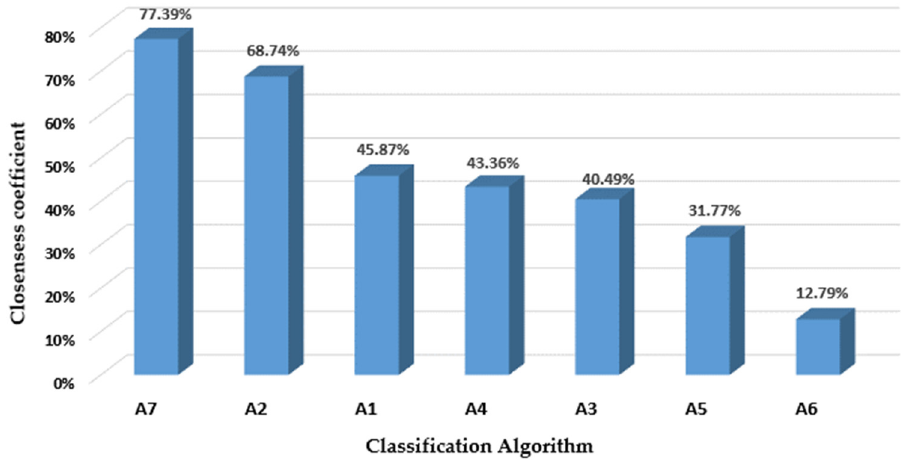
Figure 5. Ranking of alternative classification algorithms considered as a support for the adoption of a mobile-based technology in PwD.